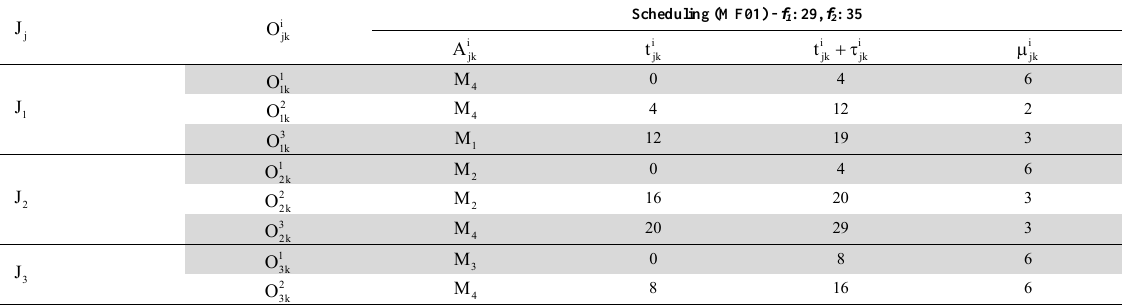
Scheduling (MF01) - f 1 : 29, f 2 : 35